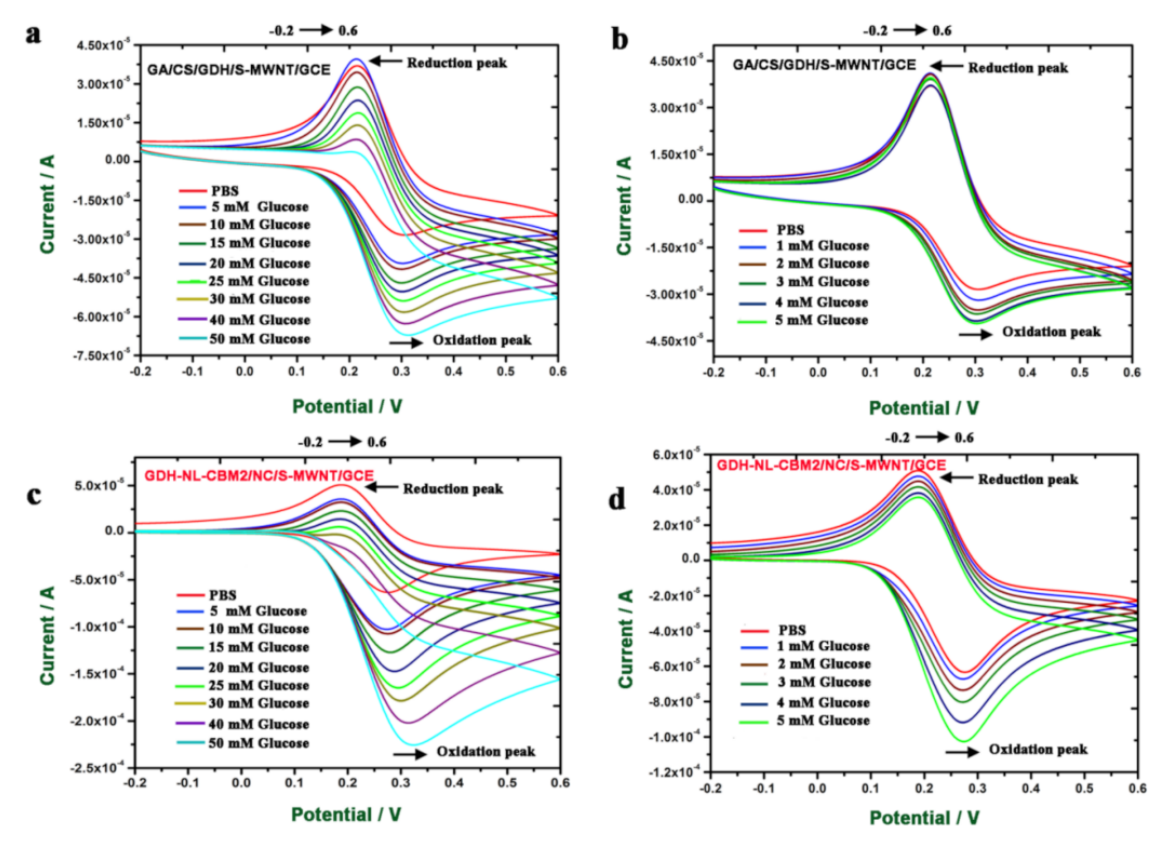
Figure 5. Cyclic voltammetry (CV) measurements of the GA/CS/GDH/S-MWCN/GCE and GDH-NL-CBM2/NC/S- MWNT/GCE responding to different concentrations of glucose. ( a ) CV measurements of GA/CS/GDH/S-MWCN/GCE responding to high concentrations of glucose (5, 10, 15, 20, 25, 30, 40, and 50 mM) dissolved in PBS (0.1 M cit- ric acid/0.2 M Na 2 HPO 4 buffer, pH 6.0, with 5 mM ferrocenylmethanol); ( b ) CV measurements of GA/CS/GDH/S- MWCN/GCE responding to low concentrations of glucose (1, 2, 3, 4, and 5 mM) dissolved in PBS (0.1 M citric acid/0.2 M Na 2 HPO 4 buffer, pH 6.0, with 5 mM ferrocenylmethanol); ( c ) CV measurements of GDH-NL-CBM2/NC/S-MWNT/GCE responding to high concentrations of glucose (5, 10, 15, 20, 25, 30, 40, and 50 mM) dissolved in PBS (0.1 M citric acid/0.2 M Na 2 HPO 4 buffer, pH 6.0,with 5 mM ferrocenylmethanol); ( d ) CV measurements of GDH-NL-CBM2/NC/S-MWNT/GCE responding to low concentrations of glucose (1, 2, 3, 4, and 5 mM) dissolved in PBS (0.1 M citric acid/0.2 M Na 2 HPO 4 buffer, pH 6.0, with 5 mM ferrocenylmethanol). The arrows indicated the scanning